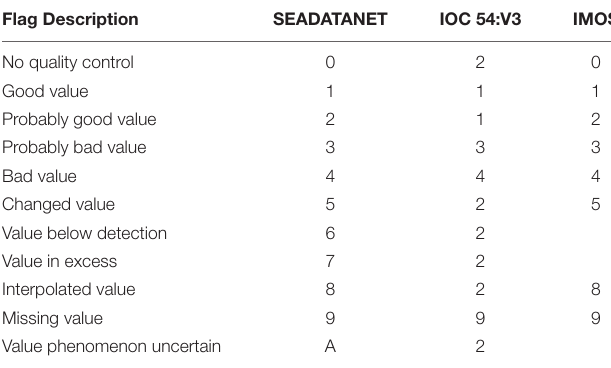
TABLE 1 | Data quality control flag translation table, SeaDataNet to IOC 54:V3 and